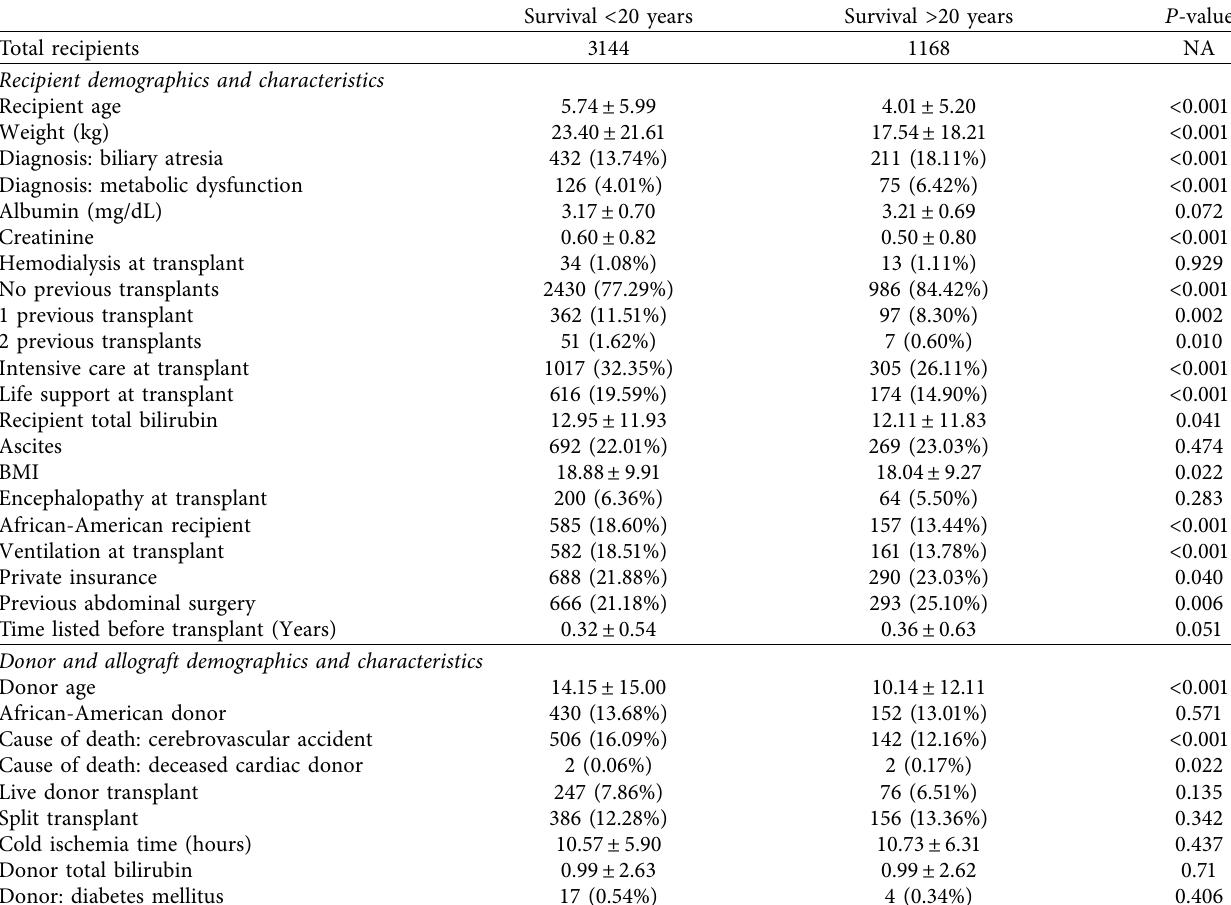
Table 1: Demographics and clinical characteristics of allografts and recipients of 1-year